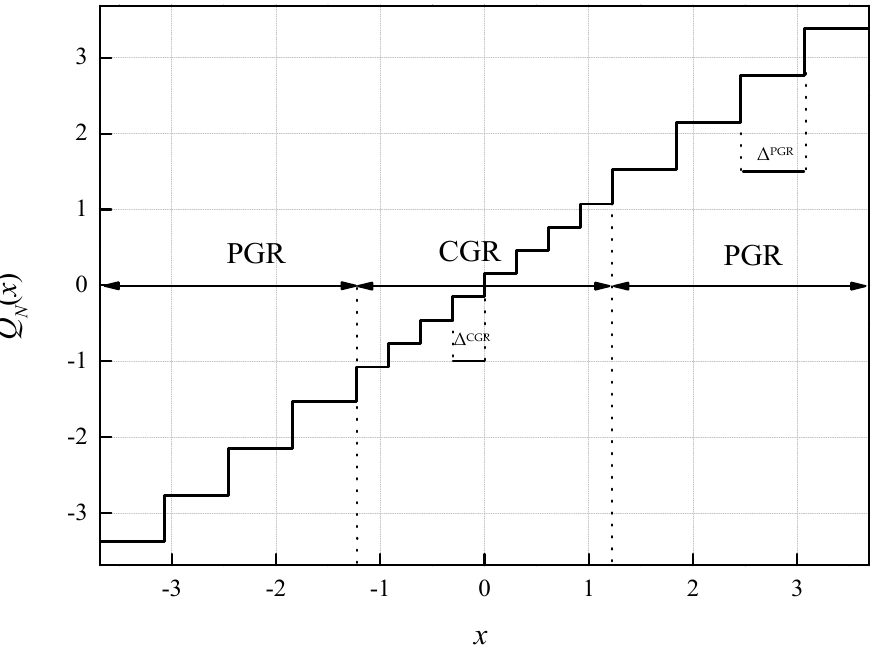
Figure 2. Transfer characteristics of PWUQ for N = 2K = 16.